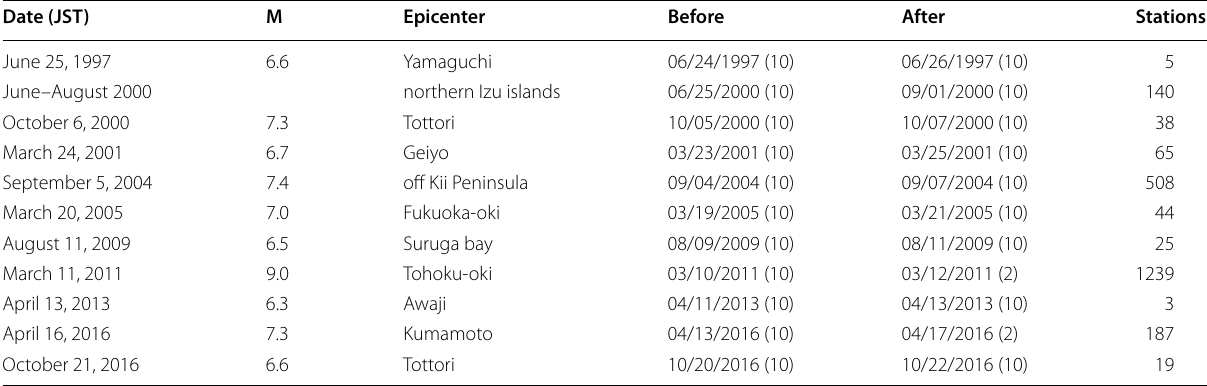
Numbers in parentheses after the dates represent the number of days used for calculating the mean of the